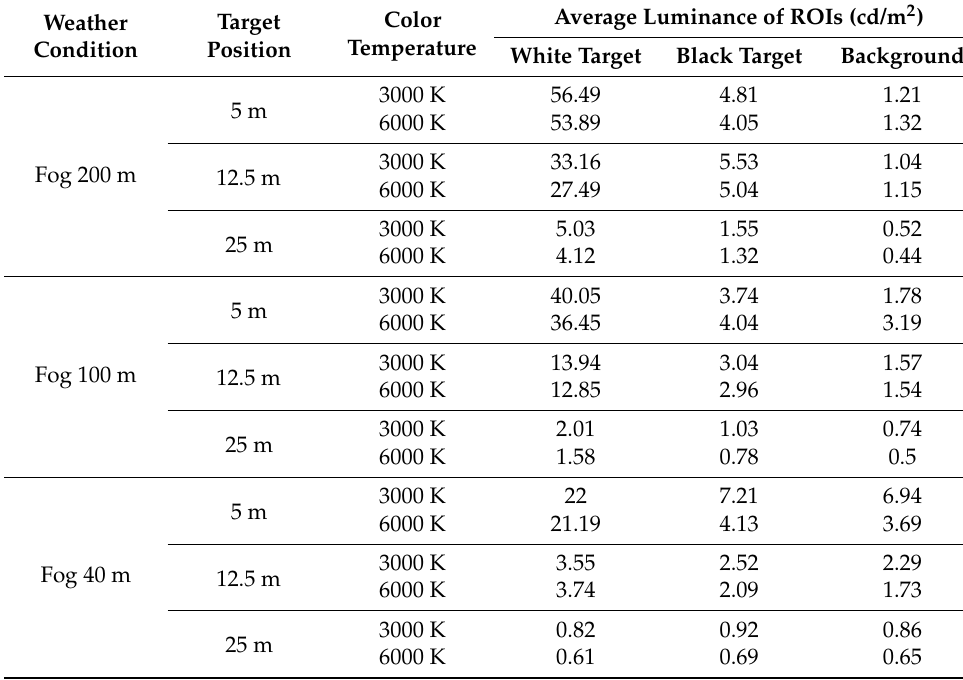
Table A2. Average luminance of ROIs in fog conditions (cd/m 2 ).